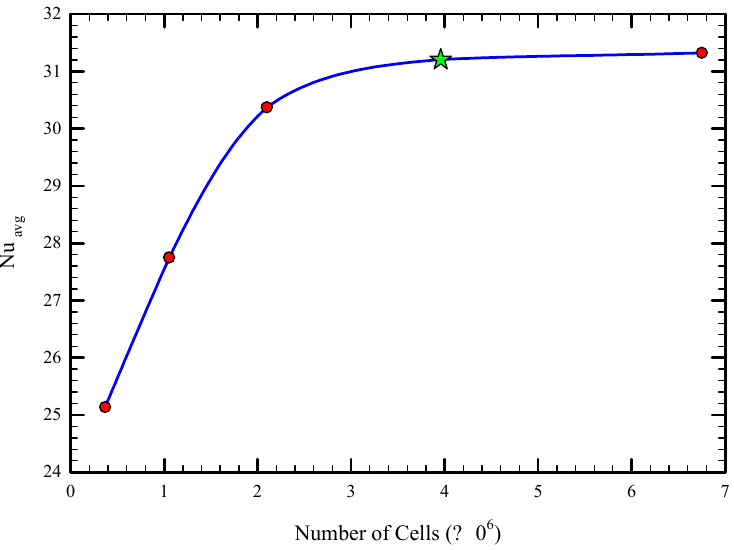
Figure 3. The grid independency analysis for the average Nusselt number for Case 5.